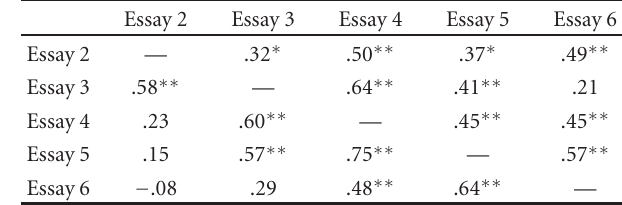
Table 2: Intrameasure correlations for bias (upper triangle) and discrimination (lower triangle) from essays 2 through 6, n =